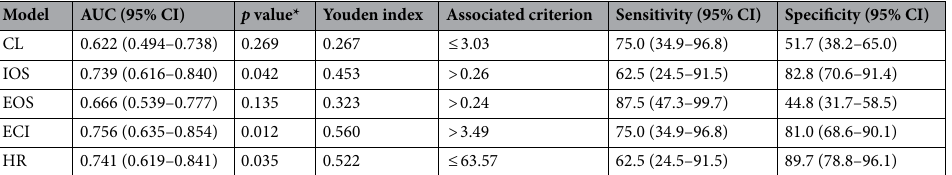
Table 5. Diagnostic performance of CL and elastographic parameters for predicting sPTD in the LEEP group by area under the ROC curve analysis. AUC area under the ROC curve, CI confidence interval, CL cervical length, ECI elasticity contrast index, EOS mean external os strain, HR , hardness ratio, IOS mean internal os strain, LEEP loop electrosurgical excision procedure, ROC receiver operating characteristic, sPTD spontaneous preterm delivery, * p value < 0.05 reflects statistical significance in predicting sPTD.